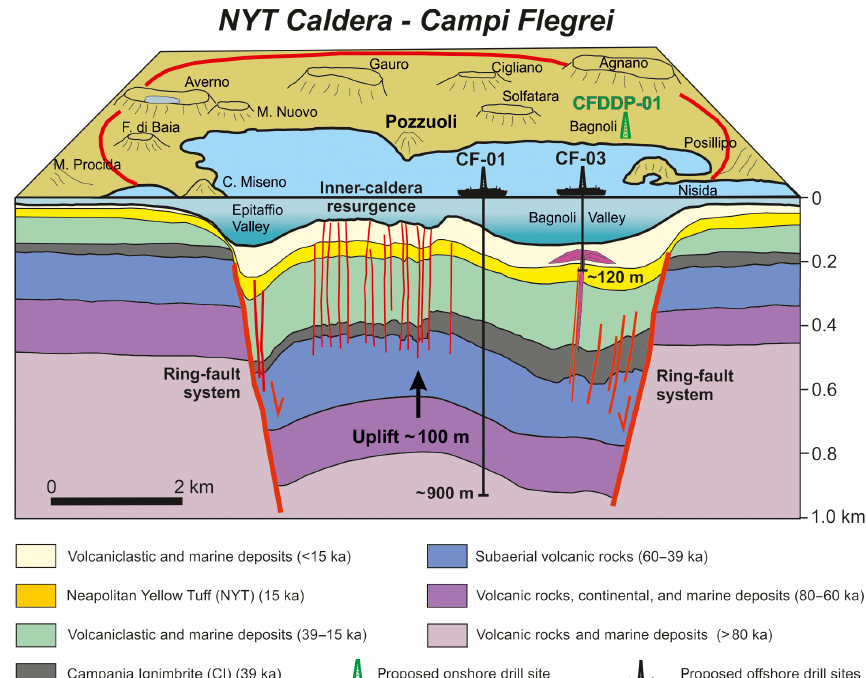
Figure 9. Schematic reconstruction of the shallow structure ( < 1km) of the collapse-resurgent caldera associated with the eruption of the Neapolitan Yellow Tuff (NYT) and the location of the proposed offshore (IODP) drill sites CF-01 and CF-03.